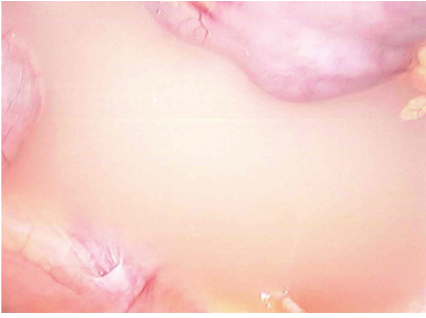
Figure 1: Diagnostic laparotomy revealed milky white ascites.